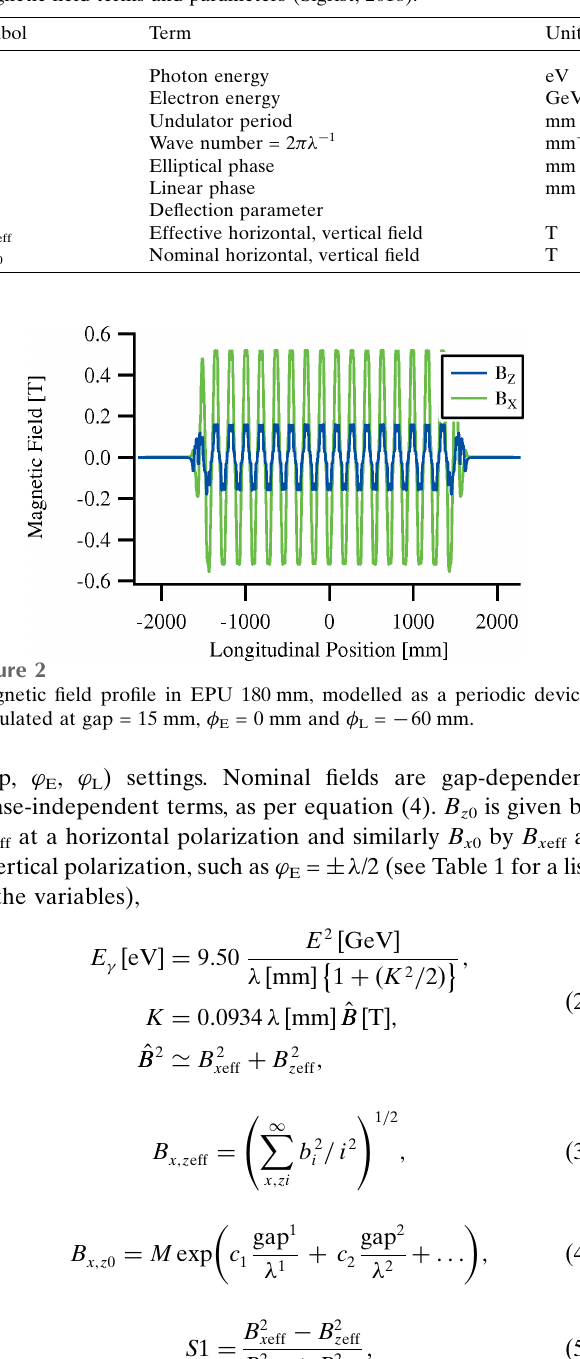
Table 1 Magnetic field terms and parameters (Sigrist, 2018).